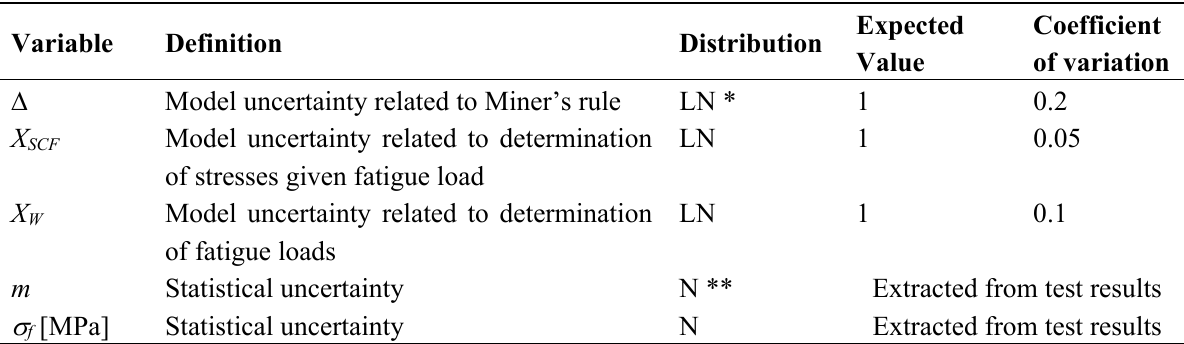
Table 1. Stochastic model.